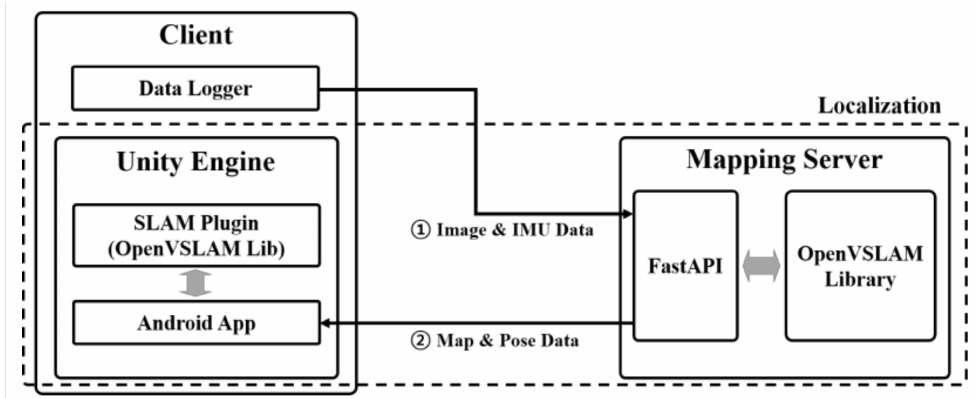
Figure 7. Interaction between mobile device and mapping server for performing SLAM based on mapping